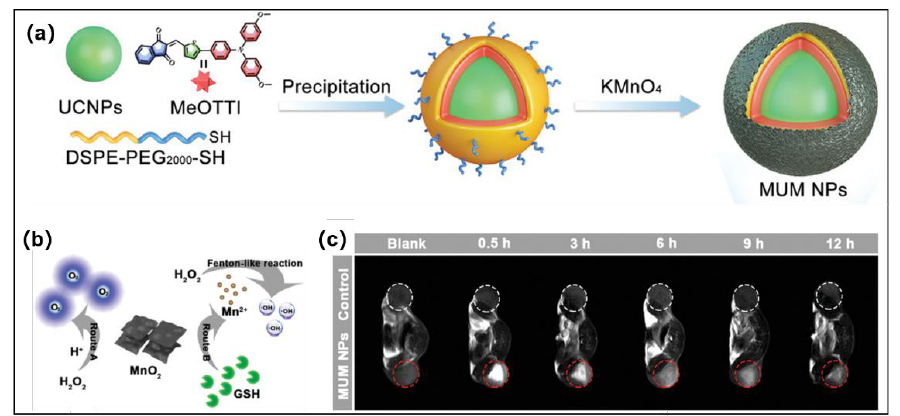
Figure 5. ( a ) Schematic illustration of chemical structures, nanofabrication of MUM nanoparticles. ( b ) Illustration of the effect of H 2 O 2 and MnO 2 in route A and route B. ( c ) Mice implanted with 4T1 tumors underwent in vivo T1-weighted MRI after being injected with MUM nanoparticle suspensions at various times. Reprinted with permission from [73].